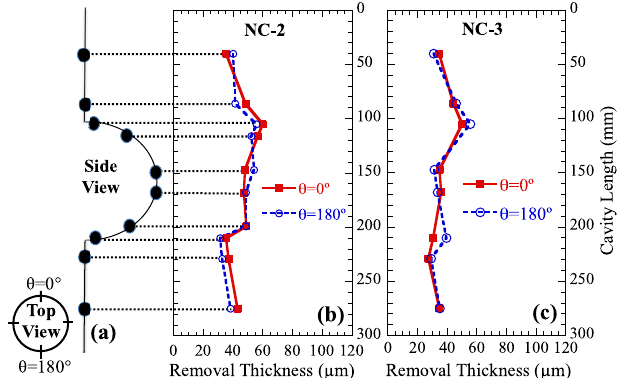
FIG. 18. (a) Black dots show positions of thickness measure- ments. Comparison of removal thicknesses along the cavity length for the VEP experiments performed with (b) NC-2 and (c) NC-3.